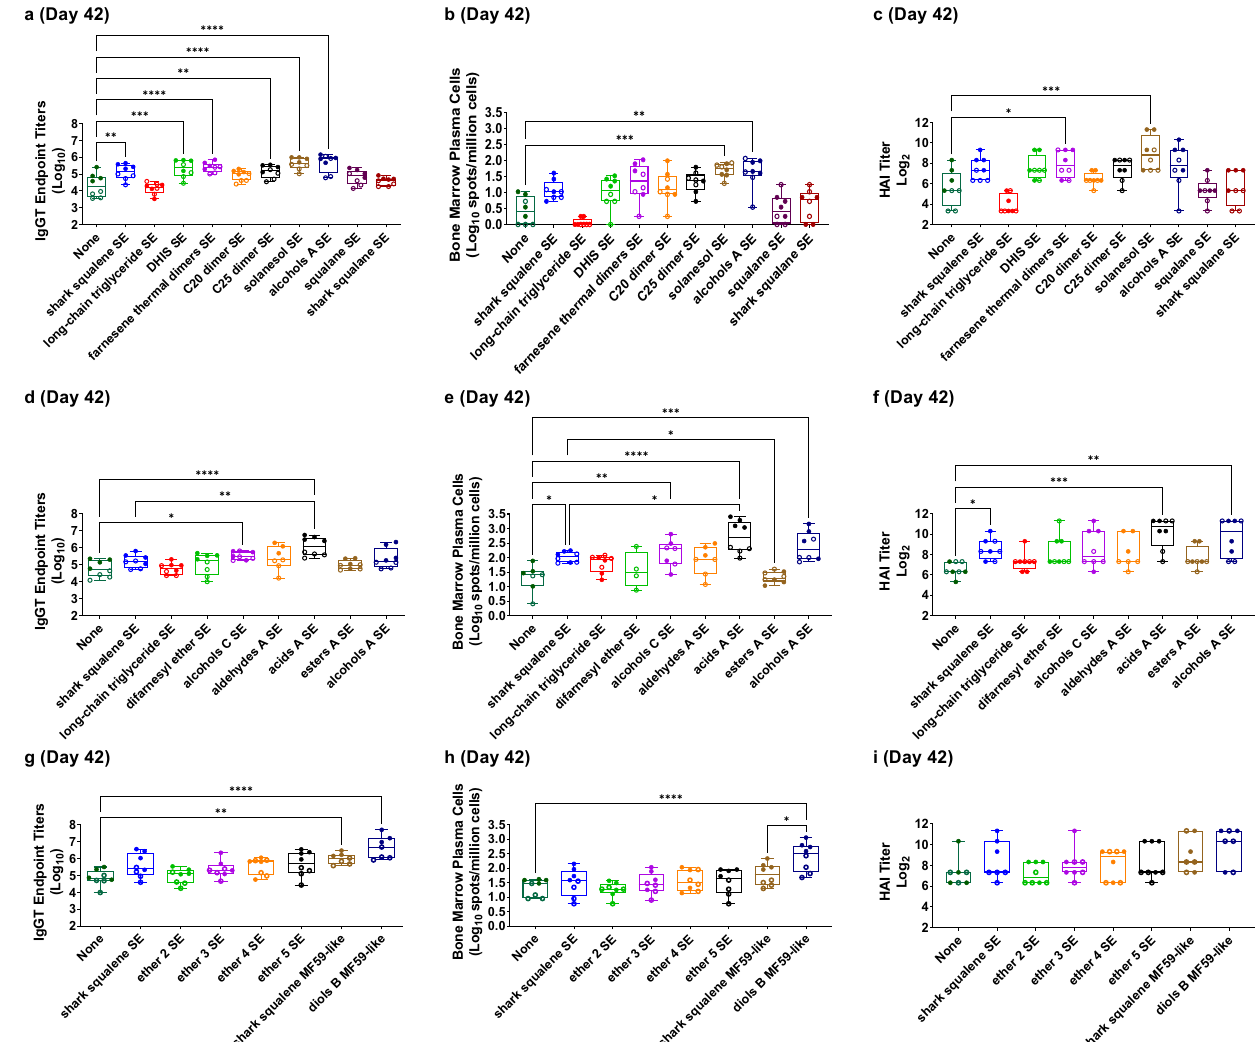
Fig. 3 Effects of terpenoid oil emulsions on antigen-speci fi c HAI, total IgG, and long-lived antibody-secreting plasma cells in mice immunized intramuscularly with split, inactivated H5N1 in fl uenza antigen mixed with terpenoid emulsions. Vaccine antigen was mixed with the indicated terpenoid oil emulsion immediately prior to intramuscular immunization of C57BL/6 mice (male [open circles] and female [closed circles]) such that each animal received 10 ng of antigen in 100 µL of 2% v/v terpenoid emulsion. Negative control groups received antigen alone (None) or antigen mixed with long-chain triglyceride emulsion. Three separate experiments each with different terpenoids as indicated are represented ( a – c , d – f , and g – i ). Data are represented as box-whisker plots with bars representing median values, boxes representing 1st – 3rd quartiles, and whiskers representing the maximum and minimum values. Statistical evaluation of each terpenoid emulsion group compared to antigen alone (negative control) and shark squalene emulsion (positive control) was performed by one-way ANOVA with Sidak ’ s correction for multiple comparisons or Kruskal – Wallis test with Dunn ’ s correction for multiple comparisons as indicated; * p -value < 0.05, ** p -value < 0.01, *** p - value < 0.001, **** p -value < 0.0001. a , d , g Antigen-speci fi c total IgG (IgGT) serum titers measured by ELISA 42days after prime immunization ( n = 7 – 8 mice, one-way ANOVA). b , e , h Long-lived antibody-secreting cells in the bone marrow measured by ELISpot assay 42 days after prime immunization ( n = 8 mice, Kruskal – Wallis for b ; n = 4 – 8 mice, one-way ANOVA for e ; n = 8 mice, one-way ANOVA for h ). c , f , i HAI titers measured 42 days after prime immunization ( n = 8 mice, one-way ANOVA for c ; n = 7 – 8 mice, Kruskal – Wallis for f , i ). See also Supplementary Figs. 7 –